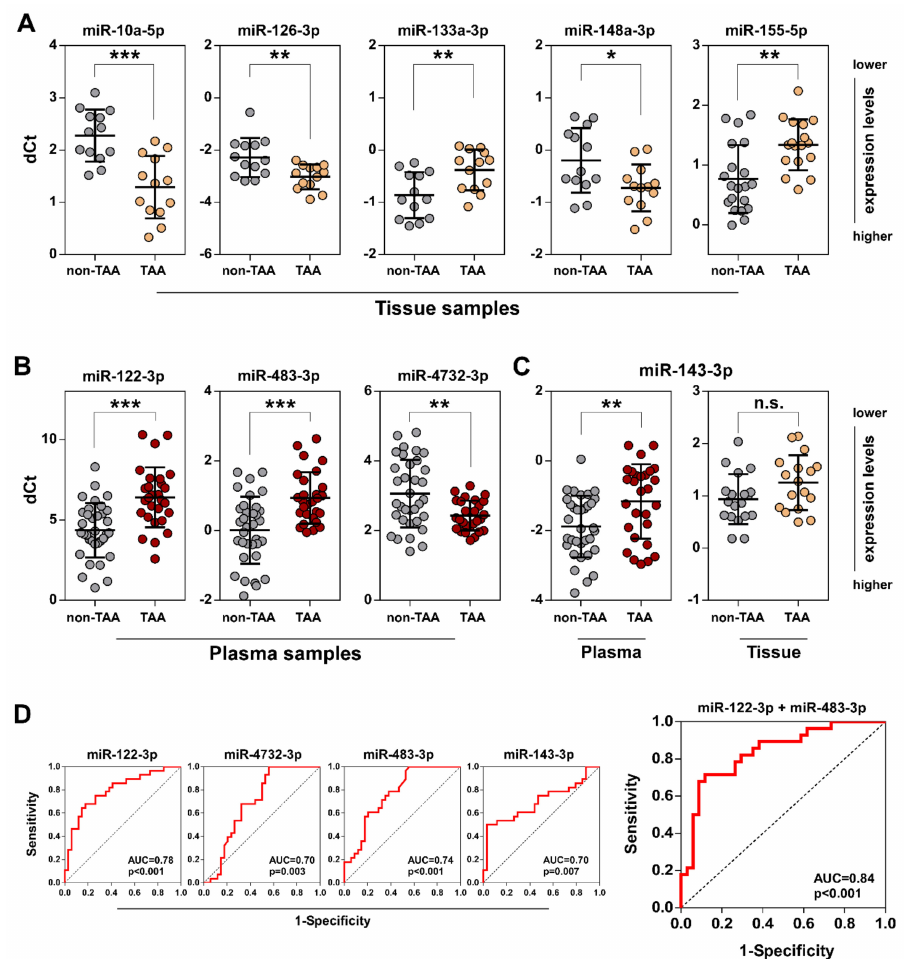
Figure 2. Validation of di ff erentially expressed miRNAs in TAA tissue and plasma samples by qRT-PCR. qRT-PCR analysis was used for the comparison of relative miRNA expression levels between non-TAA and TAA groups in tissue ( A ) and plasma ( B ) both types ( C ) of samples. The cycle threshold (Ct) values of observed miRNAs were normalized to miR-152-3p and miR-185-5p for tissue and plasma samples, respectively, which were revealed as the most reliable endogenous controls according to miRNA-Seq data. Lines within boxes indicate relative miRNA expression median values; whiskers—5–95 percentile of the relative miRNA expression values. Significance between each group was evaluated using Student’s t test and is shown as follows: n.s.—not significant; * p < 0.05; ** p < 0.01 and *** p < 0.001. ( D ) Diagnostic ROC curve analysis showing sensitivity and specificity of mir-122-3p, mir-483-3p, mir-4732-3p and mir-143-3p selected circulating miRNAs or the combination of mir-122-3p and mir-483-3p together. AUC denotes area under the ROC